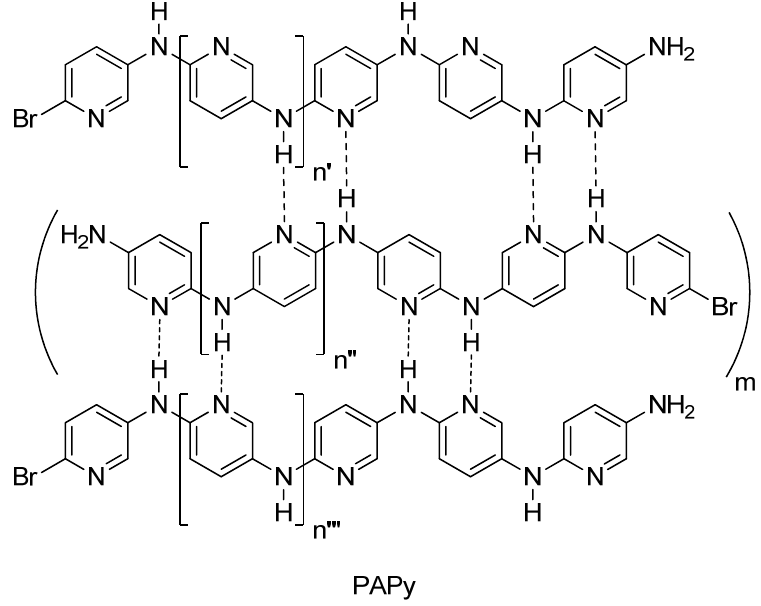
Figure 1. Schematic representation of hydrogen-bonded ladders interchains in PAPy